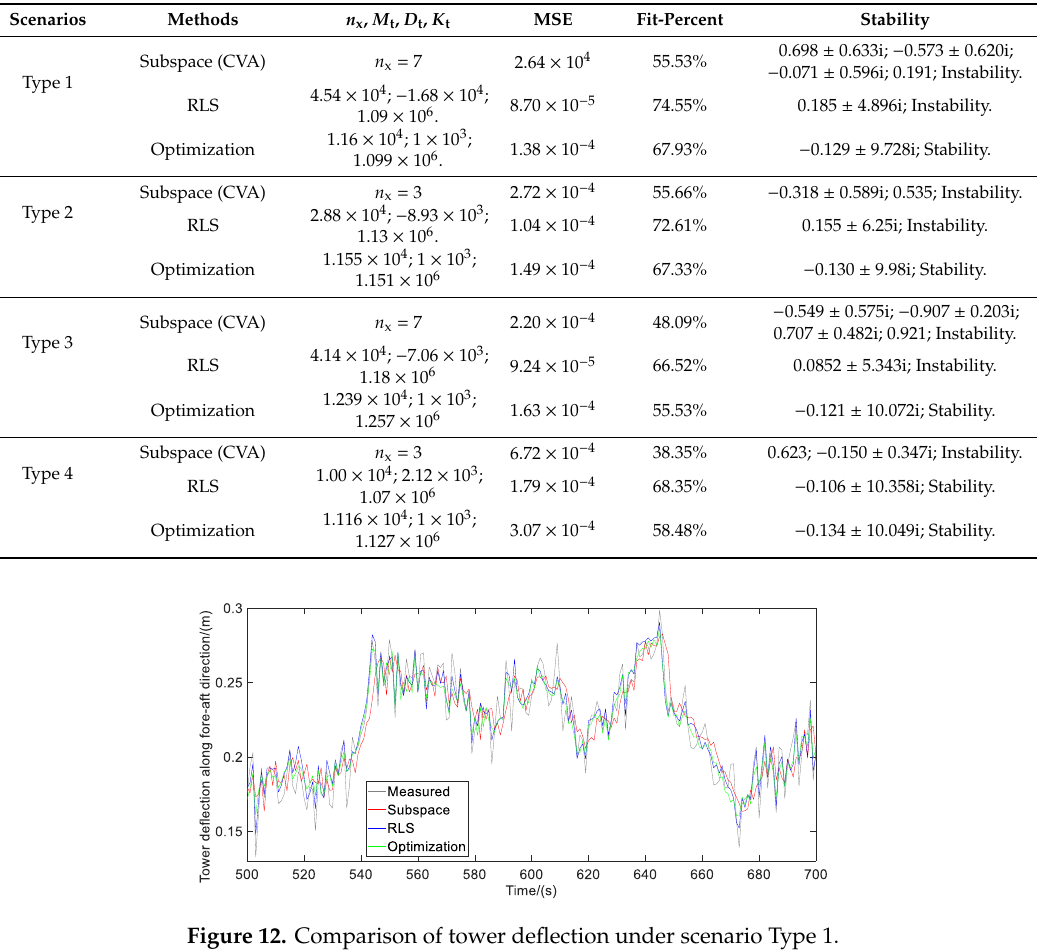
Table 7. Comparison of identification methods for tower model.